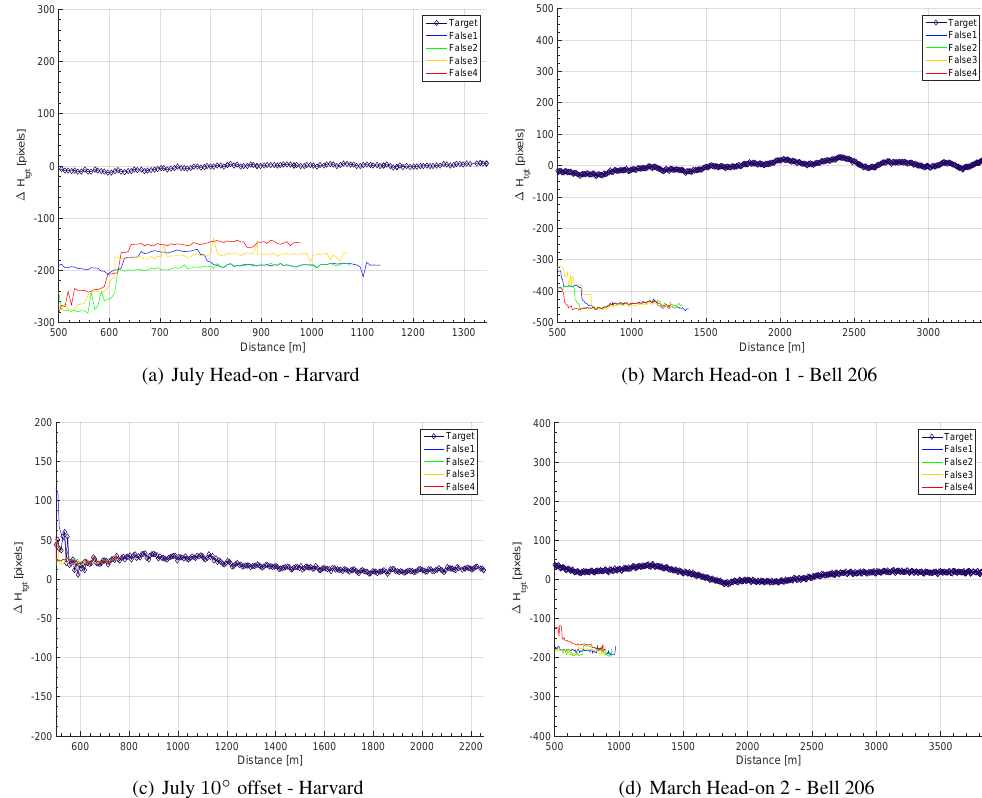
Figure 6: Comparison of true target proximity to false positives tracked across the image sequence. The abscissa denotes the range while the ordinate denotes the virtual horizon proximity (VHP) measured in pixel coordinates. Top five targets are presented. The true target, indicated by diamond markers, is observed to have the smallest | ∆ H tgt | and maintains quasi-static proximity to the virtual horizon in all four datasets. The false positives have a greater | ∆ H tgt | , but are also quasi-static with thscene. Detector